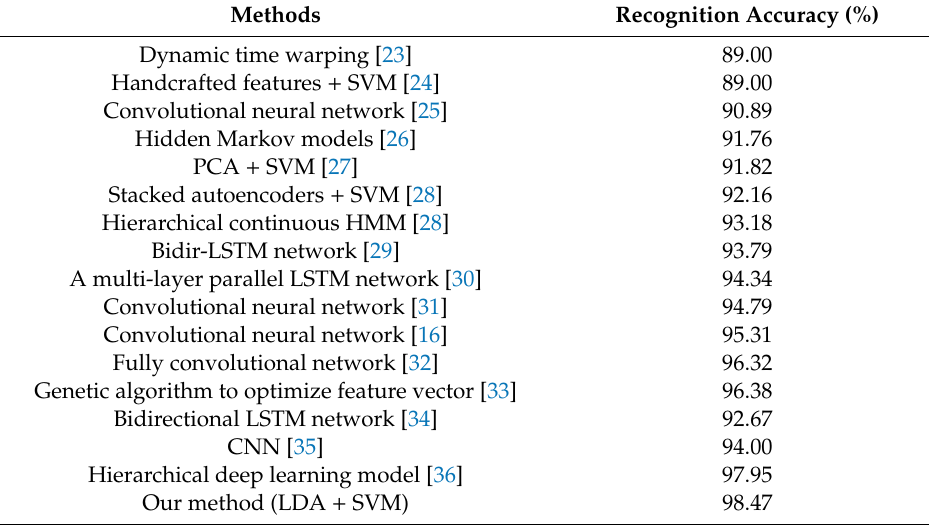
Table 5. Classification results of the UCI (University of California, Irvine) dataset.